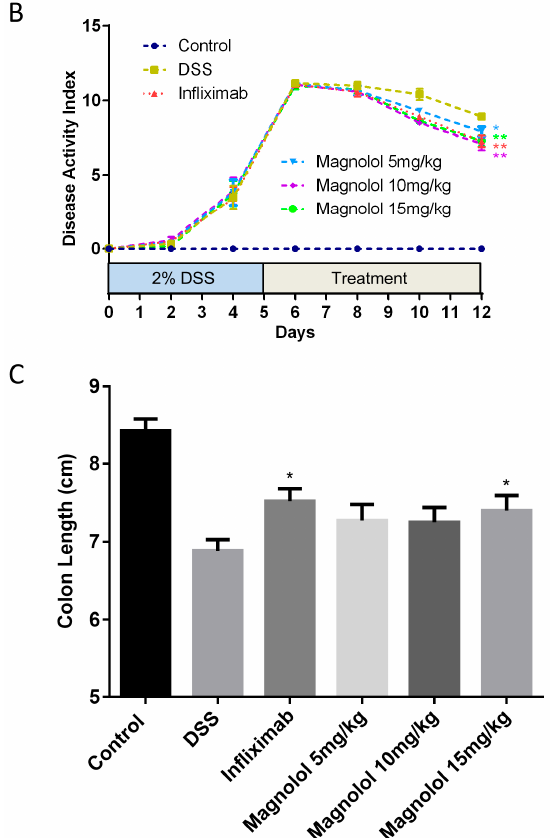
Figure 1. The phenotypic severity of dextran sulfate sodium (DSS)-induced colitis in mice can be effectively attenuated by one-week treatment of magnolol. ( A ) The body weight loss was significantly improved in all treatment groups versus DSS group; ( B ) The enhanced disease activity index of DSS mice was significantly reduced in all treatment groups; ( C ) DSS-induced shortened colon was significantly improved by high dose of magnolol and infliximab. The value in the plot was expressed as means ± SEM, and statistically significant was marked by asterisk (* p < 0.05; ** p < 0.01, vs. DSS group).